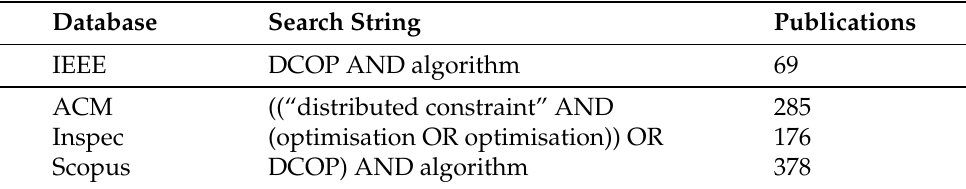
Table 1. Databases, Search strings and publications per